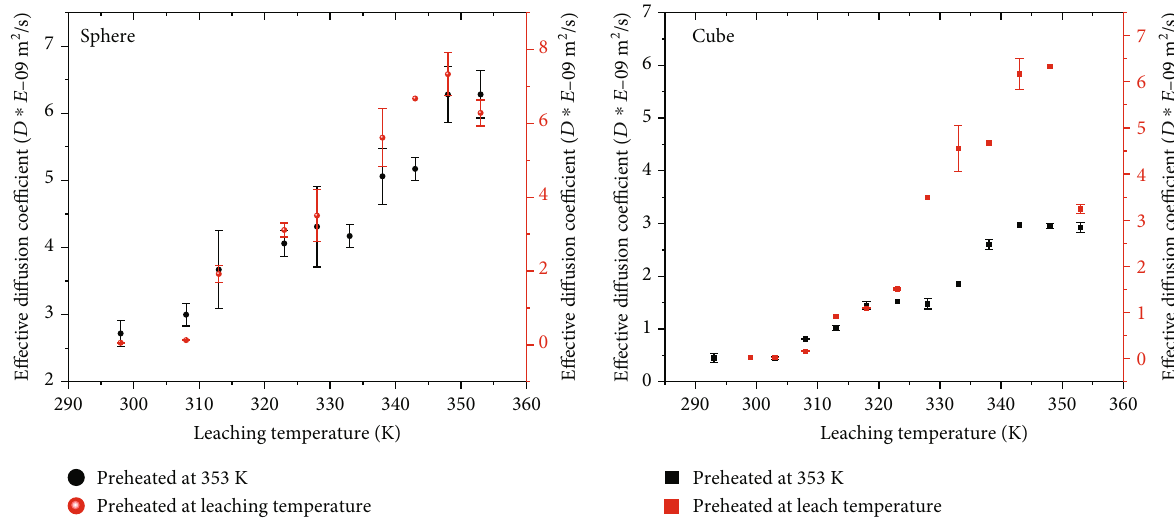
Figure 5: E ff ect of temperature on e ff ective di ff usion coe ffi cients ( D